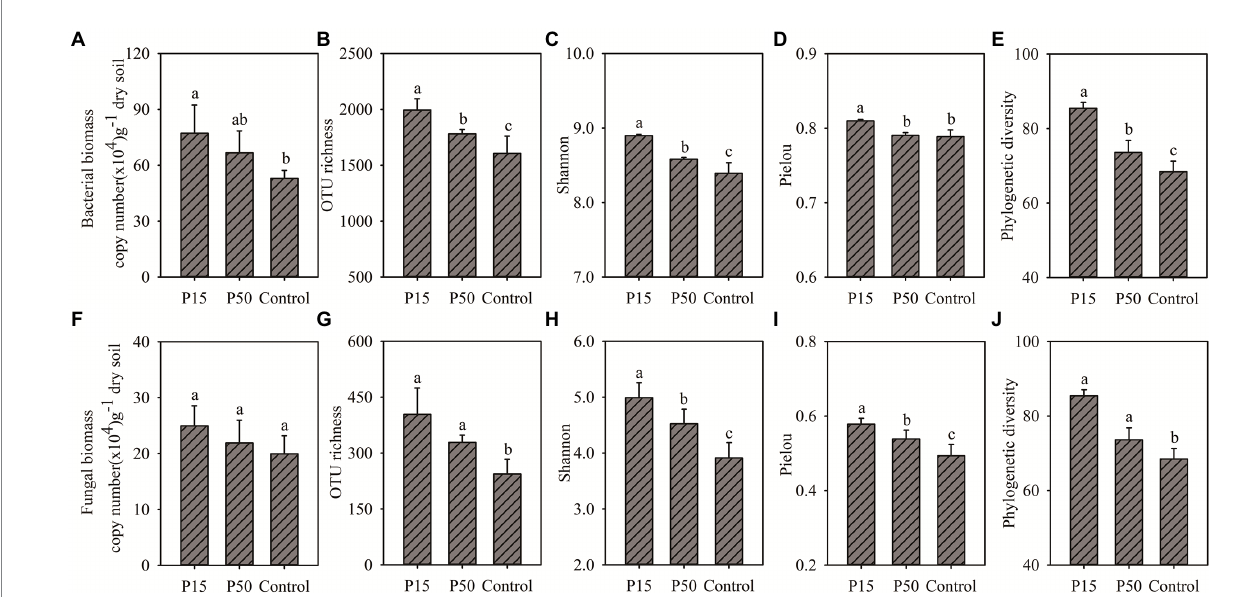
FIGURE 1 (A) Bacterial biomass, (B) Bacterial OTU richness, (C) Bacterial Shannon index, (D) Bacterial Pielou index, (E) Bacterial Phylogenetic diversity, (F) Fungal biomass, (G) Fungal OTU richness, (H) Fungal Shannon index, (I) Fungal Pielou index, (J) Fungal Phylogenetic diversity. Soil bacterial, fungal abundance and alpha-diversity under different treatments in the Cinnamomum camphora coppice planting. P15, point under the tree canopy; P50, point between trees; Control, point in the abandoned land. Bars represent mean; error bars denote standard deviation. Letters above bars represent differences from Duncan’s HSD comparisons ( p <